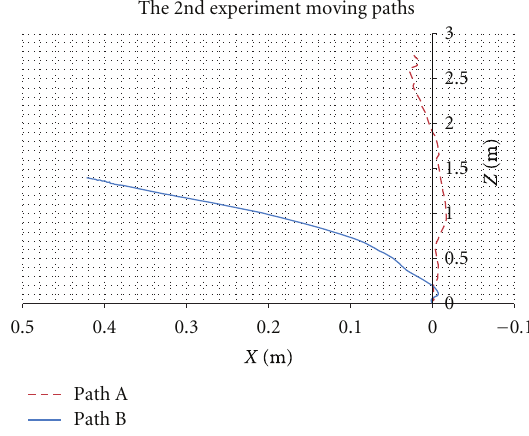
Figure 7: Ground truth of experiments.